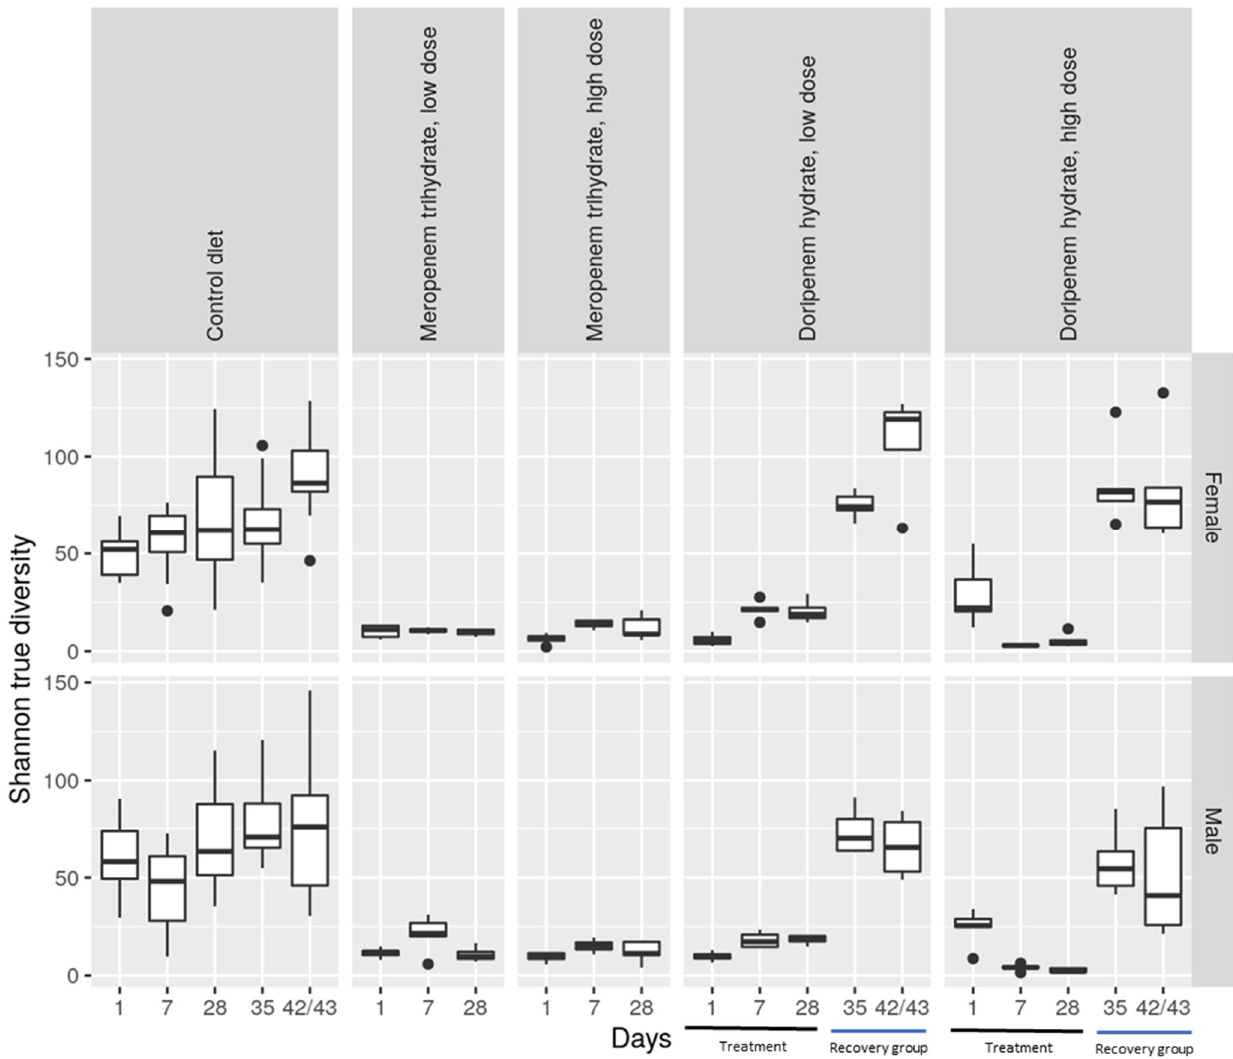
Figure 3. Shannon true diversity analysis of the antibiotic treatments, meropenem, doripenem, and controls for both male and female Wistar rats. The top row shows data for females (f) and the bottom row shows data for males (m). Doripenem treatment time points (days 1, 7, and 28) and recovery time points (days 35 and 42/43) are indicated with black and blue lines, respectively, on the x-axis. Whiskers denote standard deviations, and solid lines within the boxes indicate the group medians.